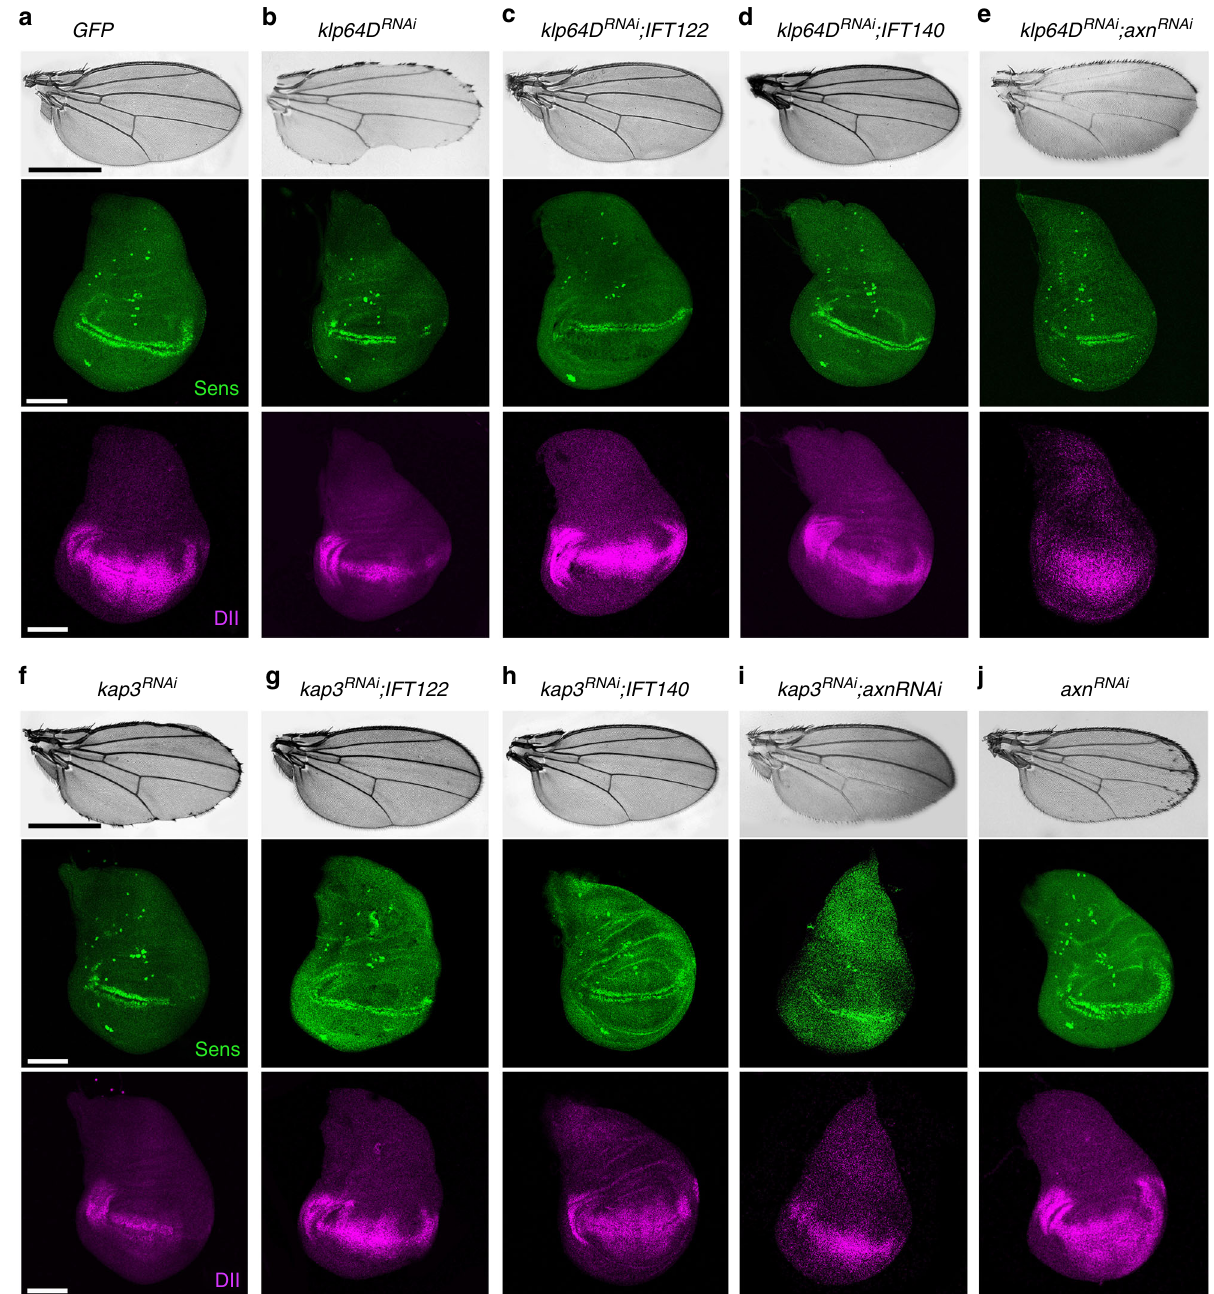
Fig. 1 Genetic interactions between kinesin-2, IFT-A components, and Wg-signaling. All panels were using the wing margin driver C96-Gal4 . Adult wings: anterior is up and distal to right; wing discs: ventral is up and anterior to the left. a UAS-GFP ( C96 > GFP ) control wing. C96 > GFP (control) with wild-type Sens (in green) and Dll (in magenta) expression at/near D/V boundary of wing imaginal discs. b C96 > klp64D RNAi , note wing notching phenotype. C96 > klp64D RNAi , note partial loss of Sens (in green) and reduction of Dll (in magenta), consistent with adult wing defects. c , d Notching caused by klp64D RNAi is suppressed by co-overexpression of IFT-A components. Genotypes as indicated above panels. Sens (in green) and Dll expression (in magenta) were restored by co-overexpression of IFT-A components. e Notching caused by Klp64D knockdown is only partially suppressed by axin RNAi . Reduction of Sens and Dll expression (see b) was only partially restored by axin knockdown (see below, panel ( j ), for axin RNAi alone as control). f C96 > kap3 RNAi , note wing notching and margin loss. Reduced Kap3 function causes partial loss of Sens and Dll expression. Margin defects caused by kap3 RNAi knockdown were suppressed by co-overexpression of IFT-A components ( g , h ), and Sens and Dll expression at the D/V boundary in C96 > kap3 RNAi is restored by co- overexpression of IFT-A components. i Margin defects caused by kap3 RNAi knockdown are partially suppressed by axin RNAi . Reduction of Sens (green) and Dll expression (magenta) are also partially rescued by Axin KD. j C96 > axin RNAi , which hyperactivates the Wg pathway, induces extra margin bristles. C96 > axin RNAi wing discs also show ectopic Sens and Dll expression. Scale bars represent 100 and 30 µ m. All the tested wings show phenotype ( n =